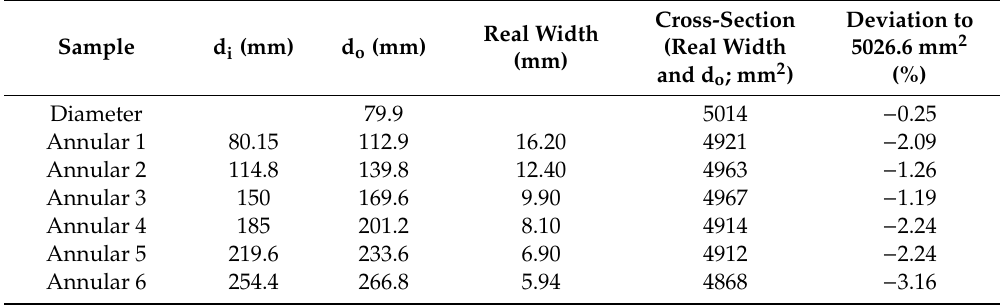
Table 3. Geometric dimensions of annular samples related to a nominal cross-section of 5026.6 mm 2 . True cross-sections calculated from d o and